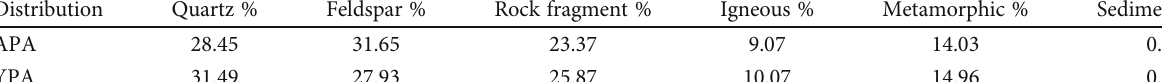
Table 1: Di ff erential statistics of the clastic component contents between the Chang 8 Distribution Quartz %